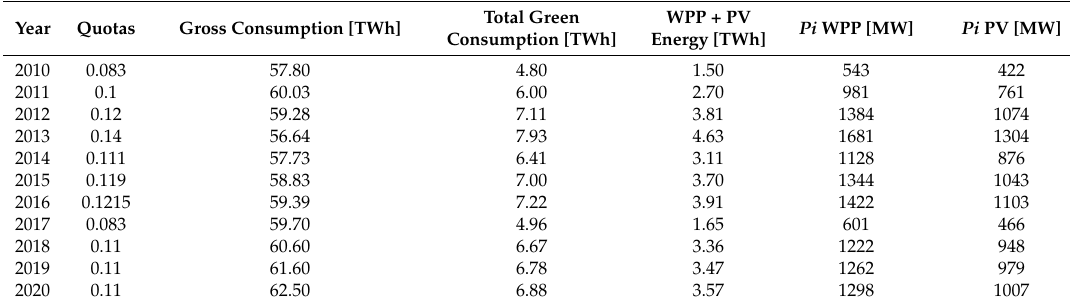
Table 2. Simulation of initial